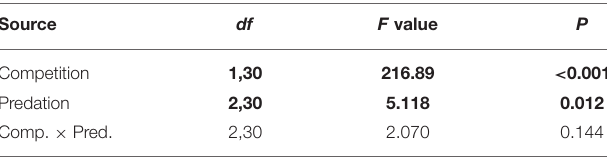
TABLE 3 | ANOVA results for mean wing length of cohorts of female Aedes aegypti larvae. Source df F value P Competition 1,30 216.89 < 0.001 Predation 2,30 5.118 0.012 Comp. × Pred. 2,30 2.070